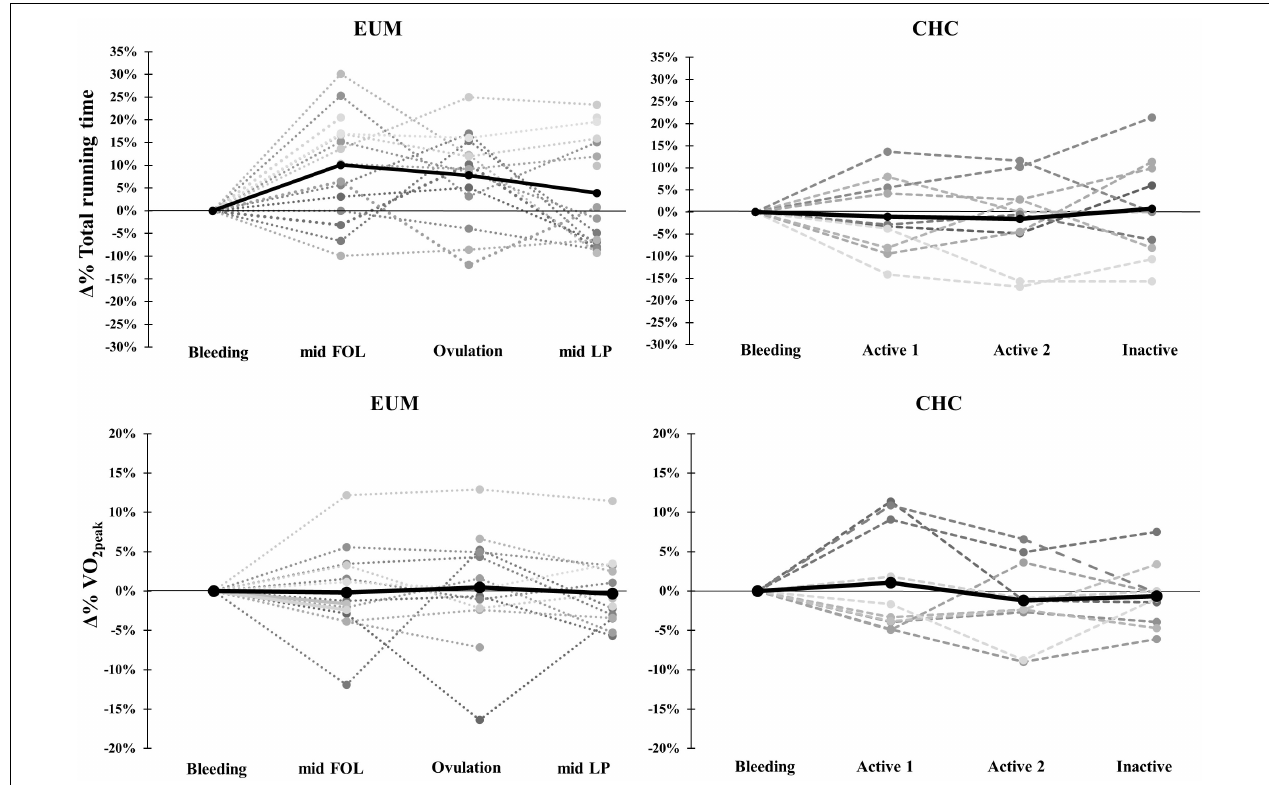
FIGURE 2 | Individual (cid:49) % changes in total running time and ˙VO 2peak in eumenorrheic (EUM) participants and monophasic hormonal contraceptive users (CHC). The solid black line represents the group